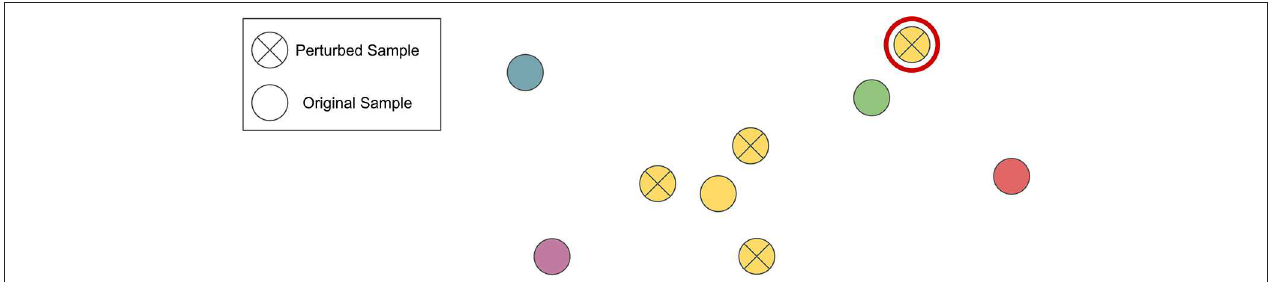
FIGURE 1 | Simplified example illustrating distance assumption within a space. Circles without a cross indicate music clips. Yellow circles with crosses refer to hardly perceptible transformations of the yellow original clip. The top-right transformation, marked with a red outer circle, actually is closer to another original clip (green) than to its own original (yellow), which violates the assumption it should be closest to its original, and hence may be seen as an error-inducing transformation under a nearest-neighbor